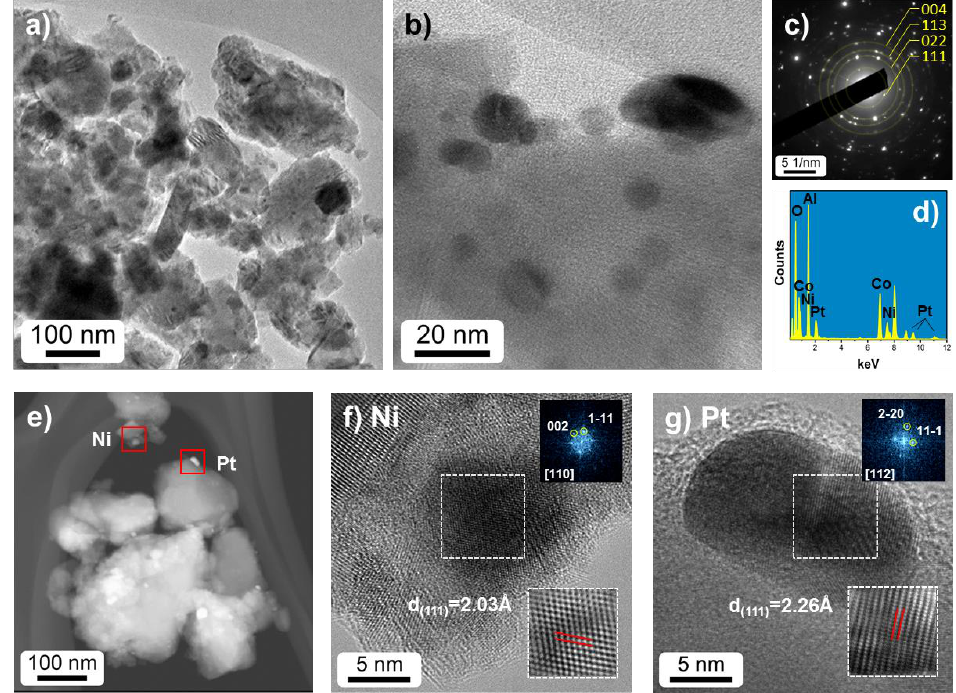
Figure 3. Microstructural analysis of Pt,Ni / CoAl 2 O 4 catalyst. ( a , b ) TEM images. ( c ) SAED (Selected Area Electron Diffraction) pattern and ( d ) EDX spectrum, both corresponding to micrograph b. ( e ) HAADF-STEM (High Angle Annular Dark Field- Scanning Transmission Electron Microscopy) images. ( f , g ) Magnified micrographs of Ni ( f ) and Pt ( g ) nanoparticles; the insets correspond to the marked area of interest: (top) filtered images of the lattice fringes, and (bottom) FFT (Fast Fourier Transform) used to identify the crystallographic planes and interplanar distances.